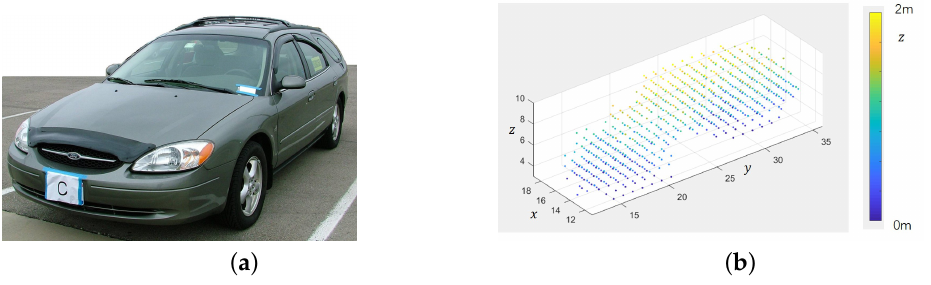
Figure 8. Comparison between real target of Vehicle C and 3D reconstruction result. ( a ) Optical image of Vehicle C. ( b ) Reconstructed 3D point cloud of Vehicle C.